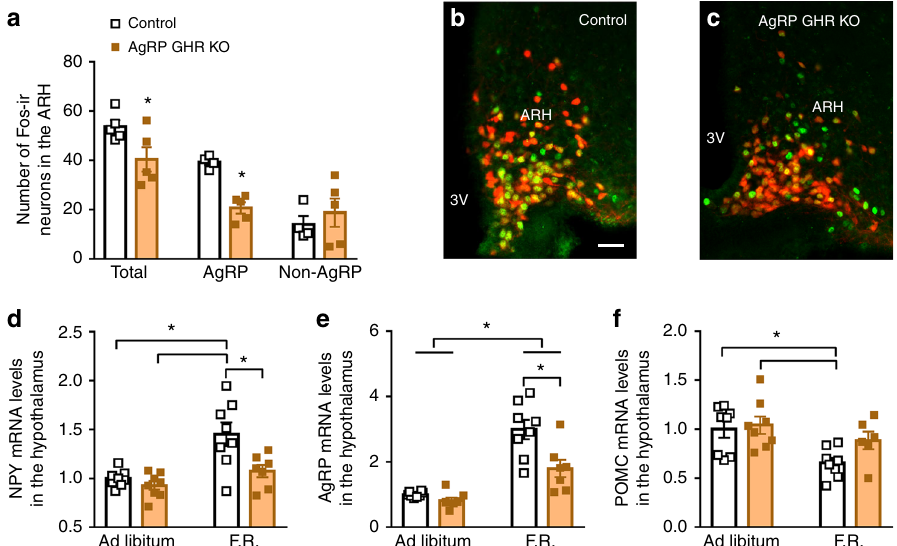
Fig. 2 Hypothalamic changes induced by weight loss are attenuated in agouti-related protein (AgRP) growth hormone receptor knockout (GHR KO) mice. a AgRP GHR KO mice show reduced number of c-Fos-positive cells after 24 h of fasting in the arcuate nucleus (ARH) ( t (8) = 2.348, P = 0.0443, n = 5) and in AgRP neurons ( t (7) = 6.62, P = 0.0003), but not in non-AgRP cells ( t (7) = 0.6529, P = 0.5347). b , c Representative photomicrographs showing fasting- induced c-Fos expression (green) and the co-localization with AgRP neurons (red). Scale Bar = 50 µ m. d Hypothalamic mRNA expression of neuropeptide Y (NPY) (main effect of food restriction (F.R.) [ F (1,27) = 16.44, P = 0.0004], main effect of GHR ablation [ F (1,27) = 9.036, P = 0.0057] and